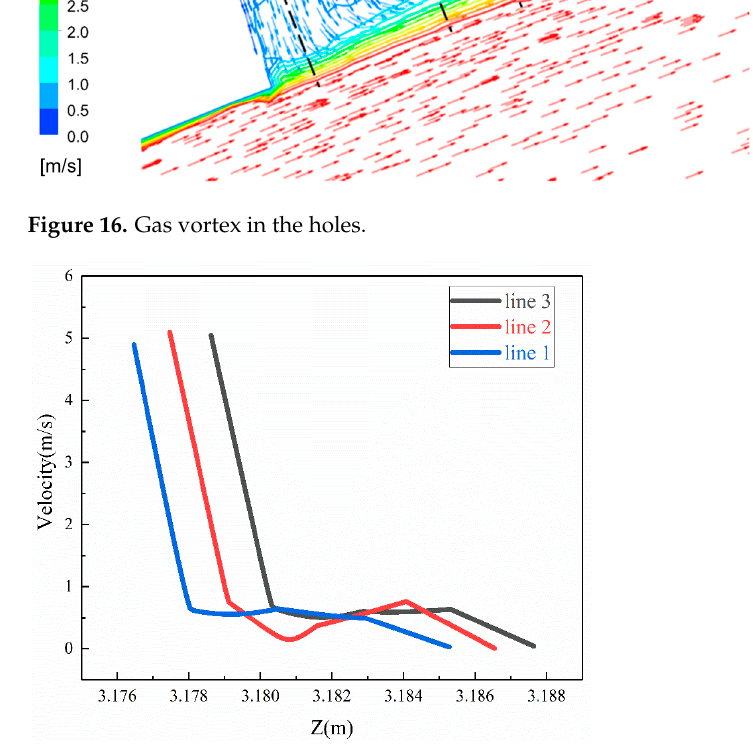
Figure 17. Velocity of gas of the three lines.